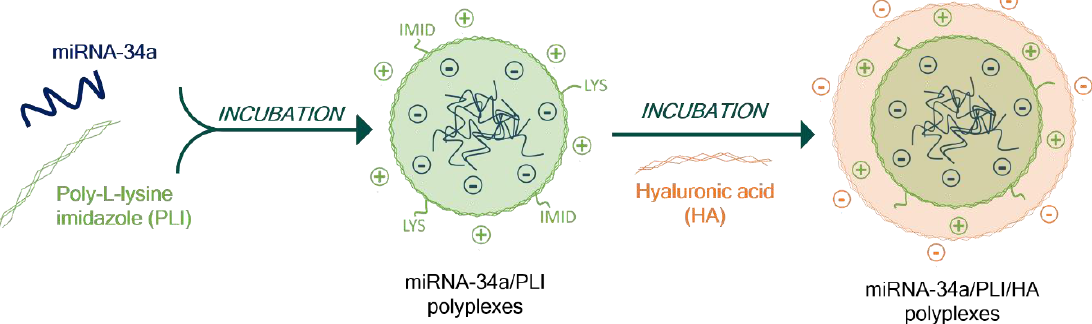
Figure 1. Schematic diagram of the key steps involved in the formation of the stable miRNA-34a / PLI / HA ternary polyplexes, showing the protonability at the endosomal environment, which allows intracellular gene delivery.